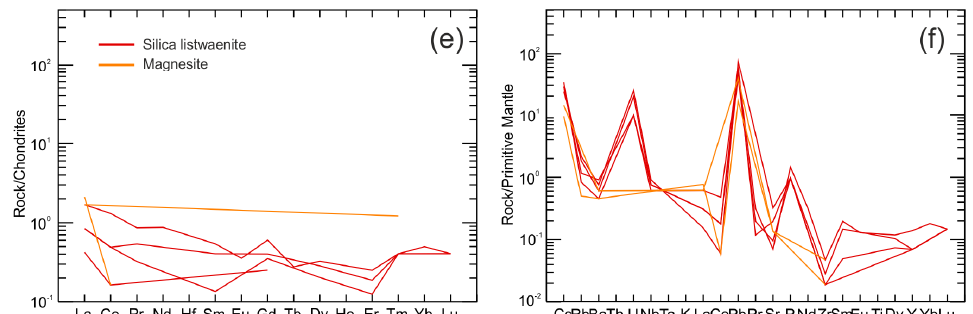
Figure 8. Geochemical diagrams ( a ) MgO vs. SiO 2 ; ( b ) V/Sc vs. SiO 2 ; ( c ) Chondrite-normalized REE patterns, after [36], of the studied unaltered and altered peridotites; ( d ) Primitive mantle-normalized multielemental patterns, after [36], of the studied unaltered and altered peridotites; ( e ) Chondrite- normalized REE patterns of the studied listwaenites and magnesites; ( f ) Primitive mantle-normalized multielemental patterns of the studied listwaenites and magnesites. Grey field peridotites reported by [16]; blue field serpentinites from Vardar derive ophiolitic remnants, reported by [38].